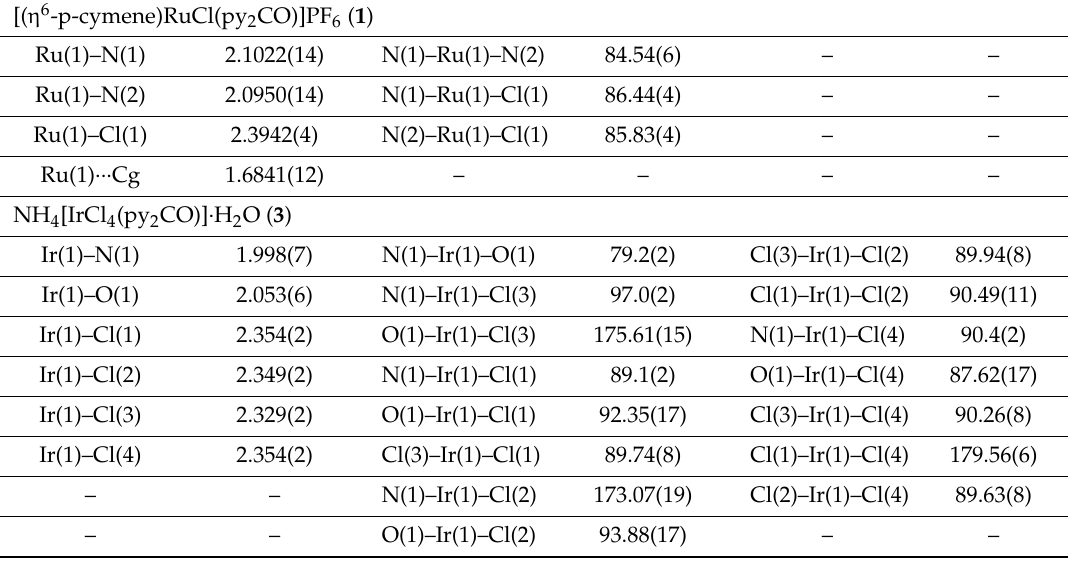
Table 2. Bond lengths [Å] and angles [deg.] for 1 and 3